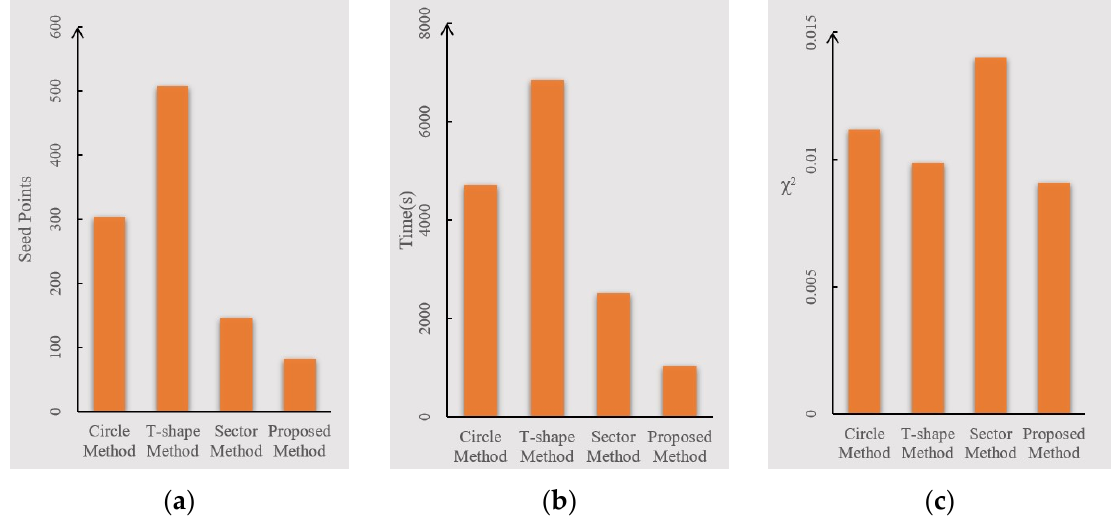
Figure 19. Statistical chart of experimental data analysis. ( a ) Statistical chart of total number of seed points; ( b ) statistical